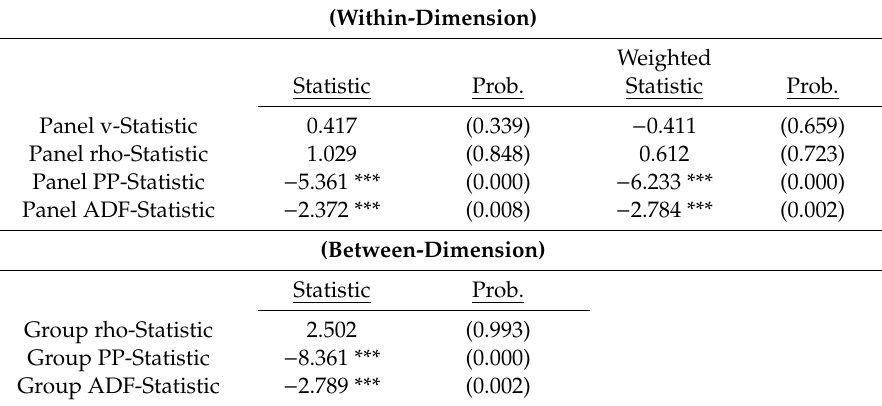
Table 4. Panel Cointegration test results with intercept and trend.